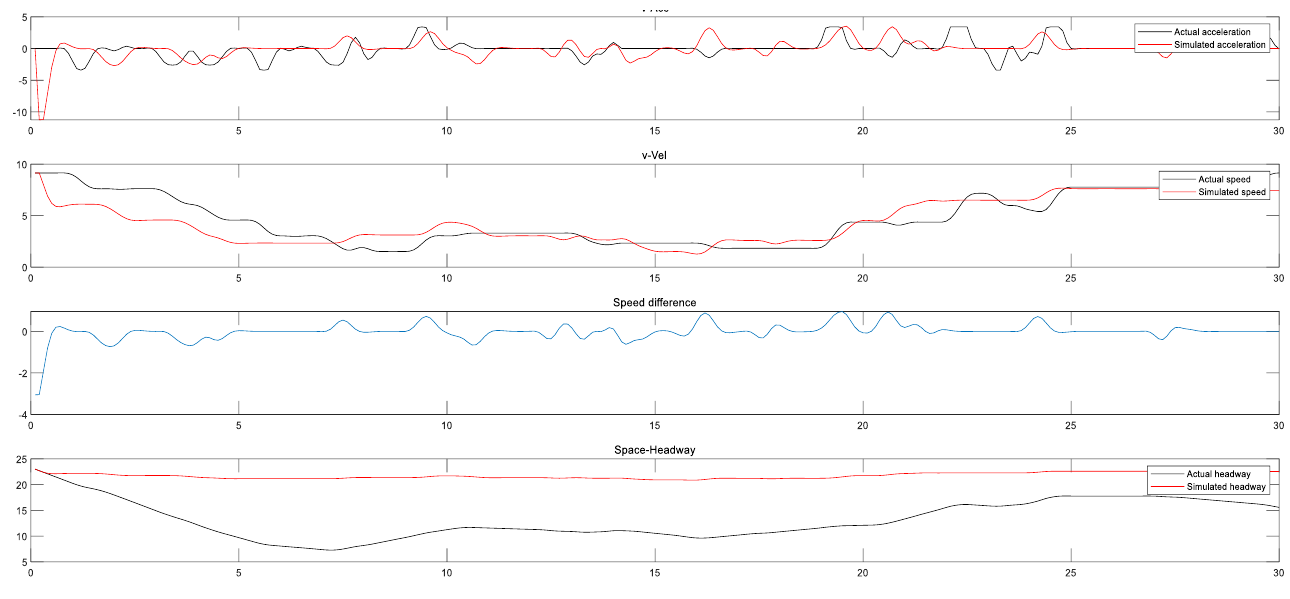
Figure 12. Simulation results of the stimulus-response model under velocity excitation.